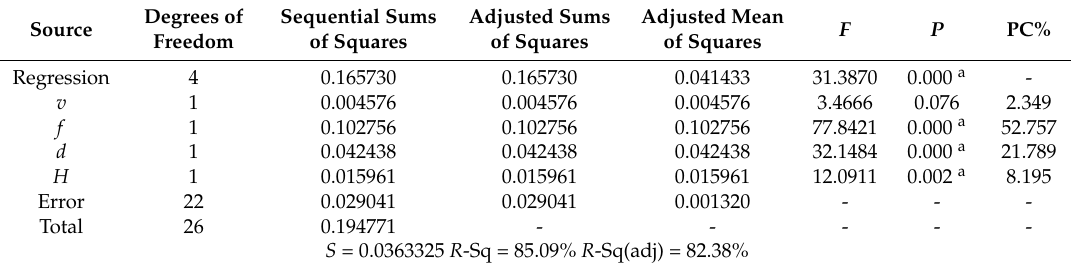
Table 12. Analysis of variance for the linear regression model.